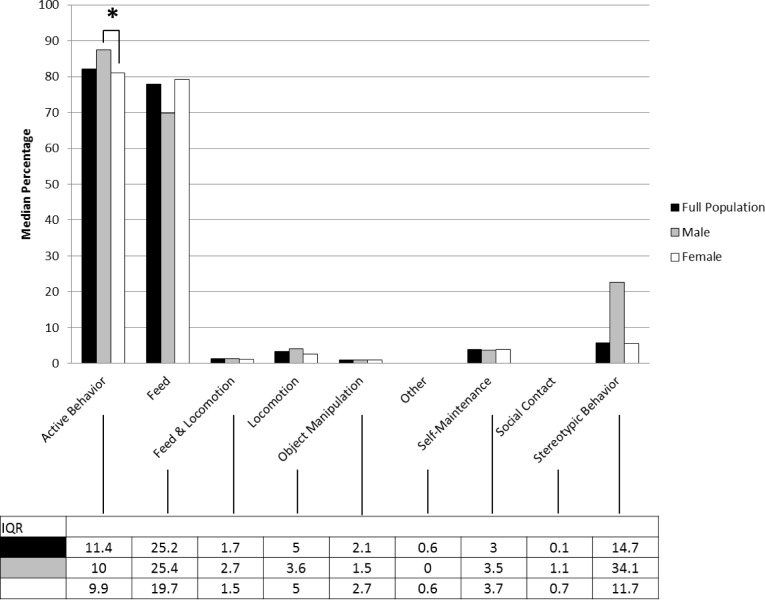
Median daytime active behavioral observation percentages and interquartile ranges.Asterisks represent significant sex differences (p<0.05). For the full population, males and females, the median values for Other and Social Contact were zero.